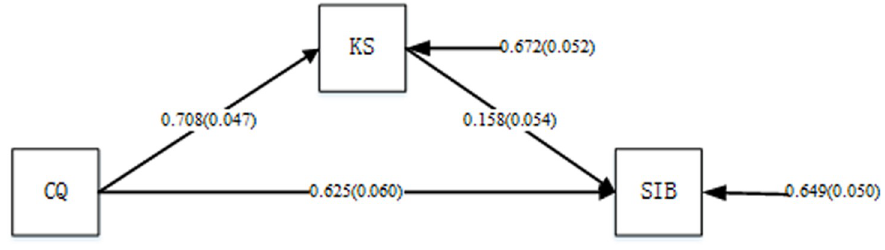
Fig 2. The basic structure equation model analysis.